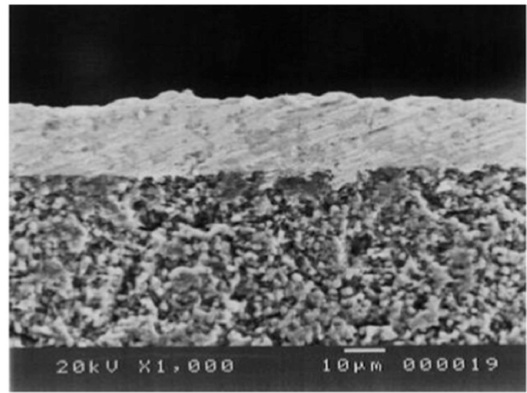
Figure 12. Cross section SEM image of a cermet membrane (top part) on a porous alumina support (bottom part). Reprinted from [197] with permission from Elsevier.